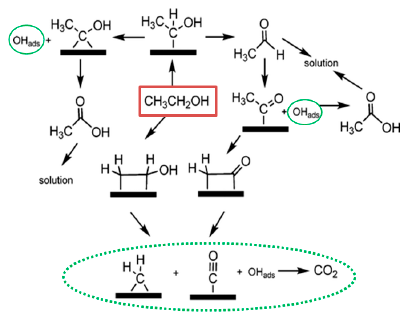
Figure 7. Ethanol oxidation reaction pathway.